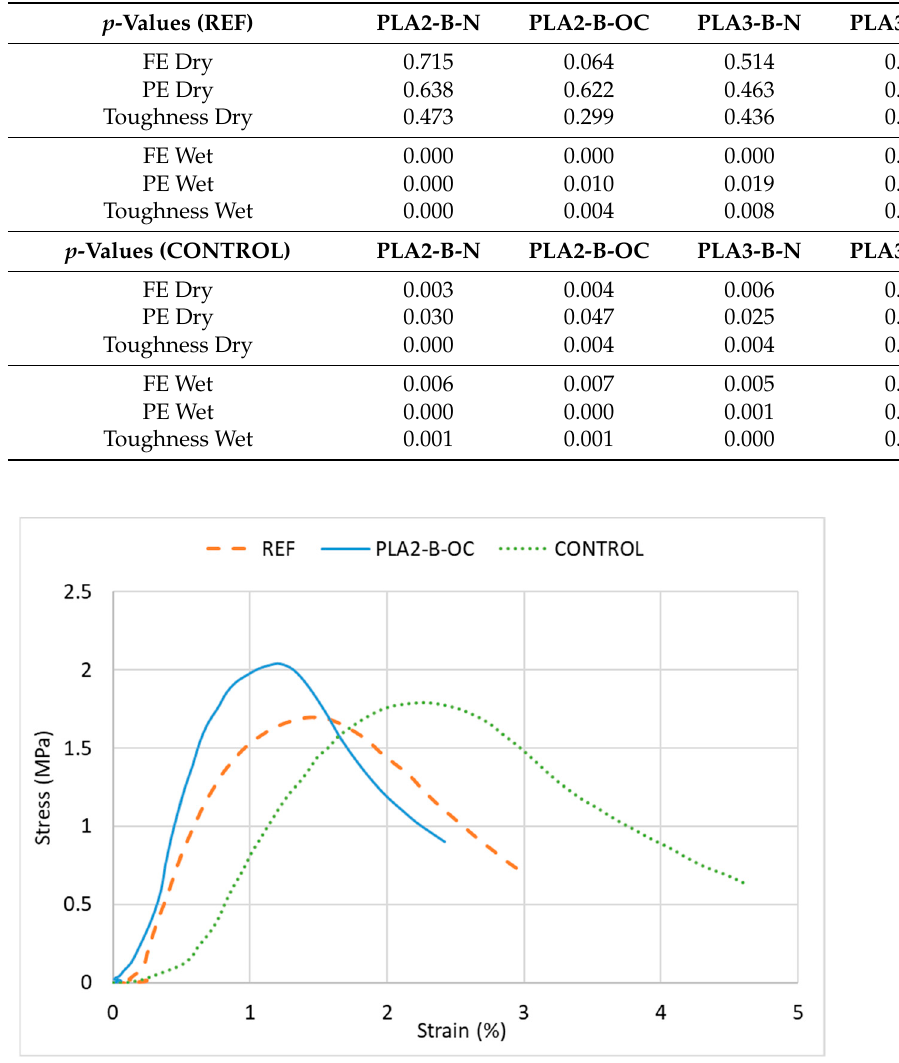
Figure 9. Stress–strain curves for three example specimens.